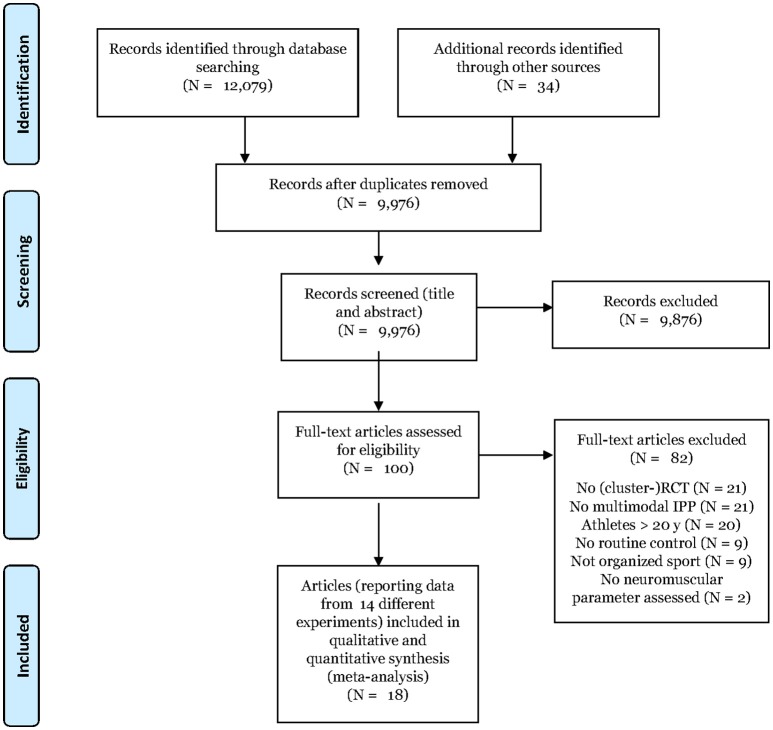
PRISMA flow diagram.